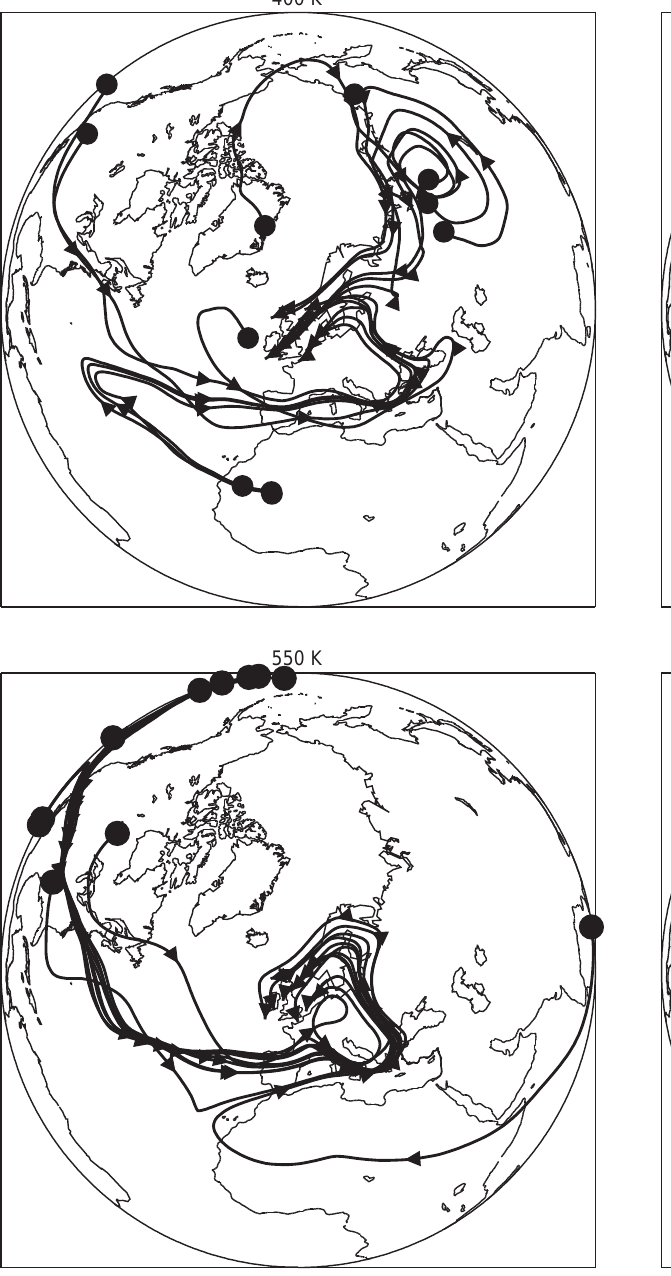
Fig. 6. As Fig. 5 but for trajectories ending on 2